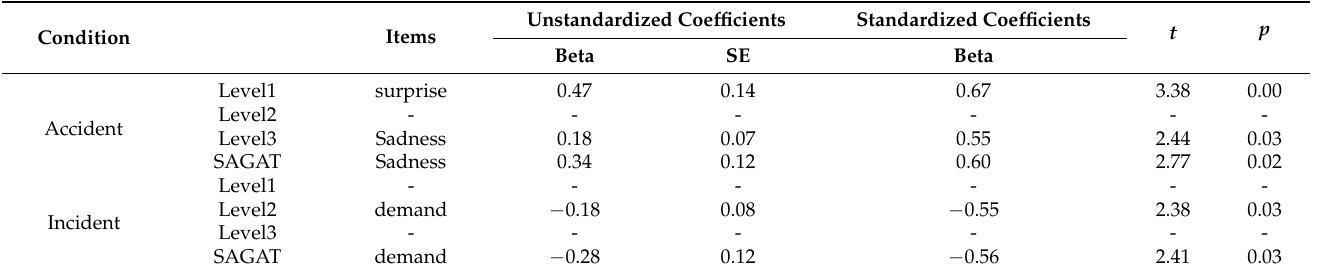
Table 2. The multiple linear regression models of induced condition on SA.